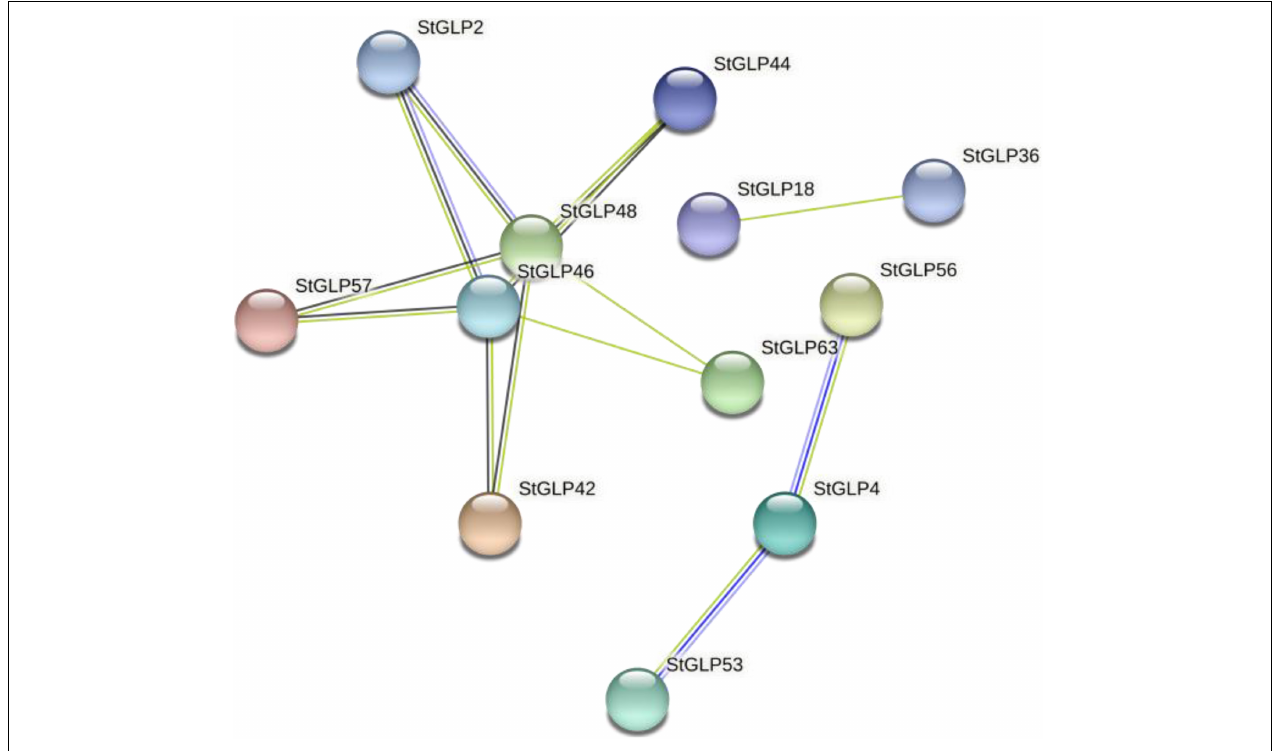
FIGURE 7 | Protein–protein interaction network of StGLPs